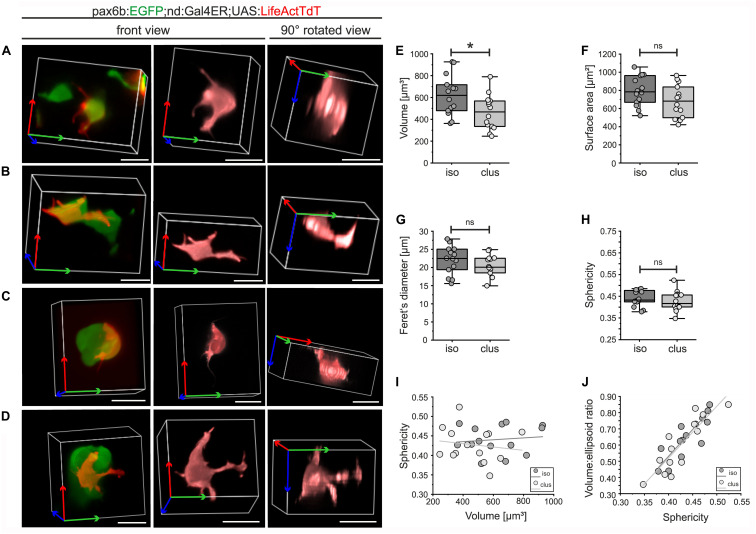
3D morphology of isolated and clustered secondary islet cells. pax6b:GFP;nd:Gal4ER;UAS:LifeActTdT larvae were treated by Notch inhibitor at 4 dpf followed by Tam treatment (for details see Supplementary Table S2). Representative single LifeActTdT-labeled cells categorized as isolated (A,B) or clustered (C,D), shown in the context of nearby pax6b:GFP+ islet cells (left), as a surface rendering in the original orientation (center), and rotated 90 degrees (right). (E) Cell volume is decreased in clustered (clus) as compared to isolated (iso) cells (t-test, p = 0.02), while surface area, Feret’s diameter and sphericity are similar between the 2 groups ((F–H), see Supplementary Table S3). (I) Scatter plot of volume versus sphericity, followed by linear regression analysis, showed no correlation for isolated or clustered cells (slope∼0). (J) Volume:ellipsoid ratio versus sphericity showed a positive correlation of these parameters, with no difference between the groups (see Supplementary Table S4). For (E–J), isolated cells n = 14; clustered cells n = 14. *p < 0.05; ns, not significant. Scale bars, 10 μm.